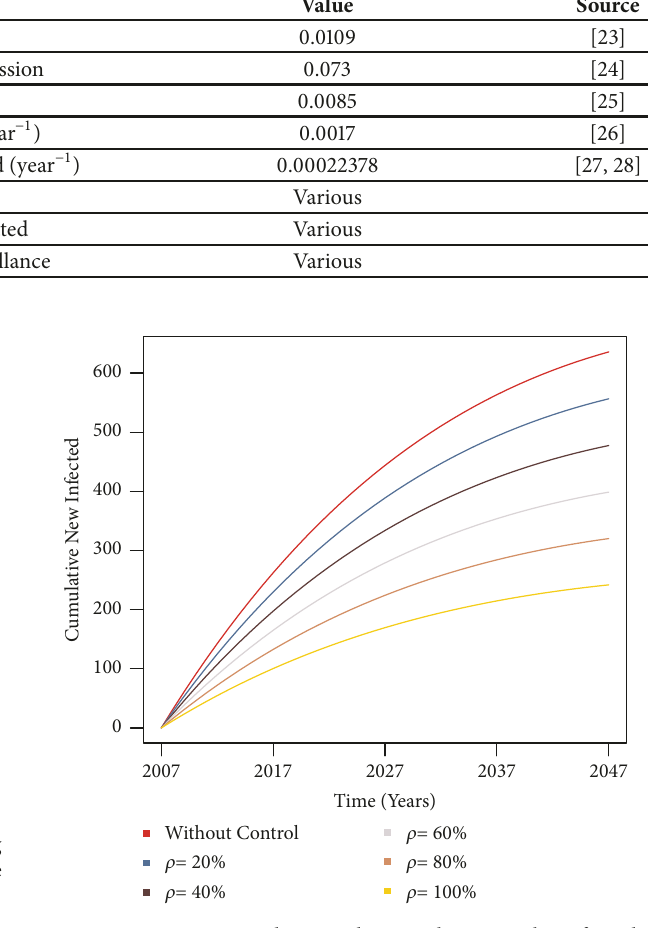
Figure 4: Sensitivity analysis on the cumulative number of newly infected individuals by varying 𝜌 , i.e., the proportion of treatment of infected